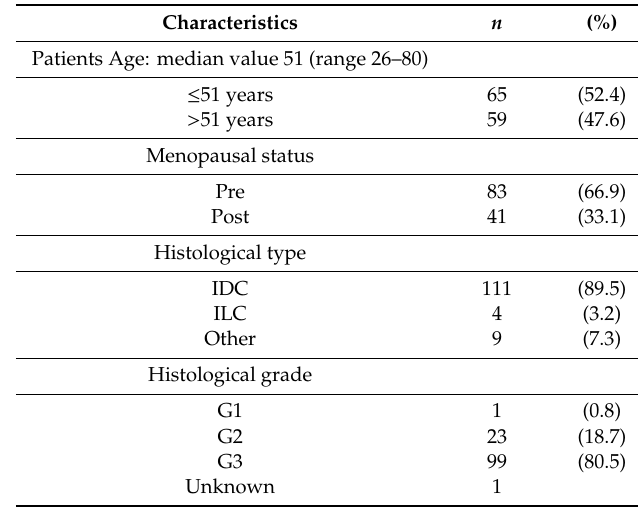
Table 4. Clinicopathological characteristics of 124 triple negative breast cancer (TNBC)